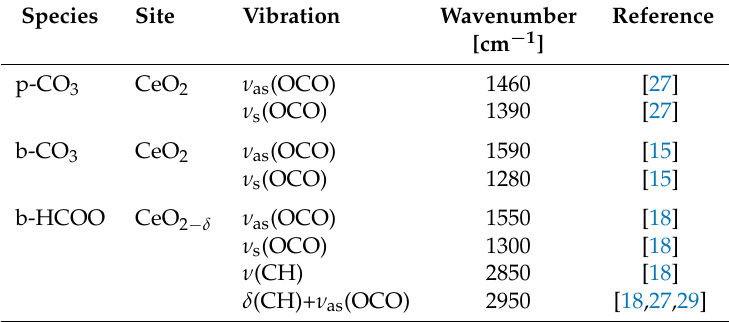
Figure 4. Phase resolved spectra in the 3800–2700 cm − 1 region (0 ◦ ≤ θ PSD ≤ 180 ◦ ), showing responding hydroxyl and C–H vibrations. Table 2. Infrared peak assignments for the transient experiments in the 1700–800 cm − 1 region. The wavenumber values are approximated ( ± 10 cm − 1 ) due to fluctuations during the time series and between the different